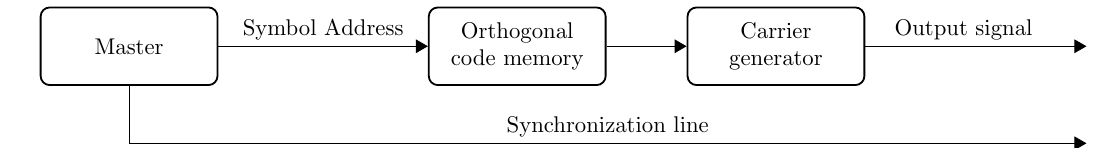
Figure 2. FPGA transmitter logic.